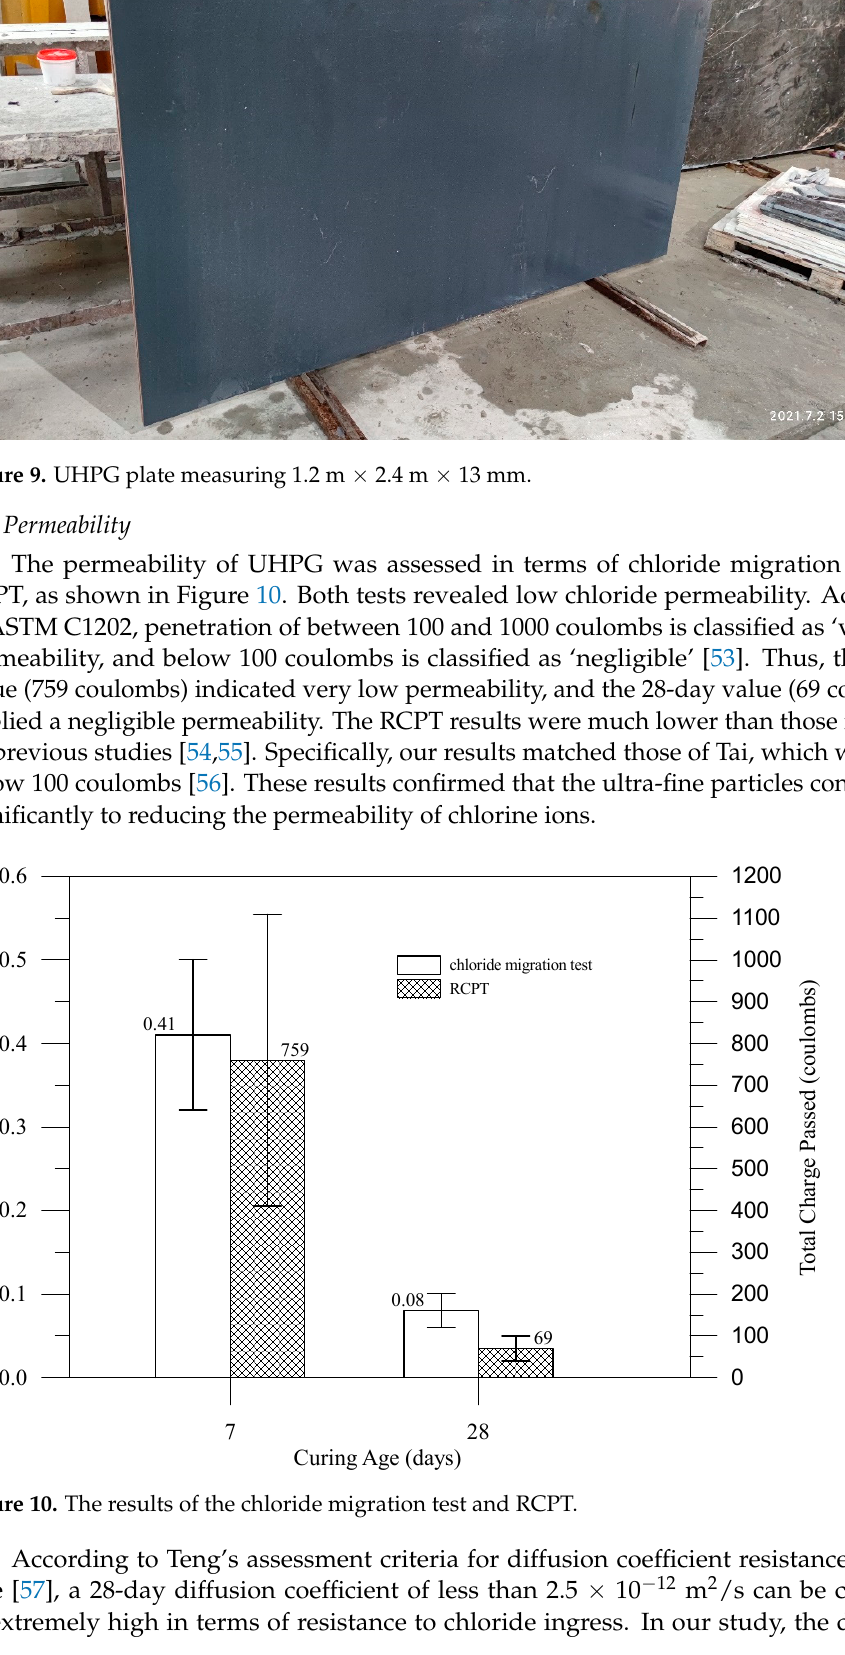
Figure 9. UHPG plate measuring 1.2 m × 2.4 m × 13 mm.